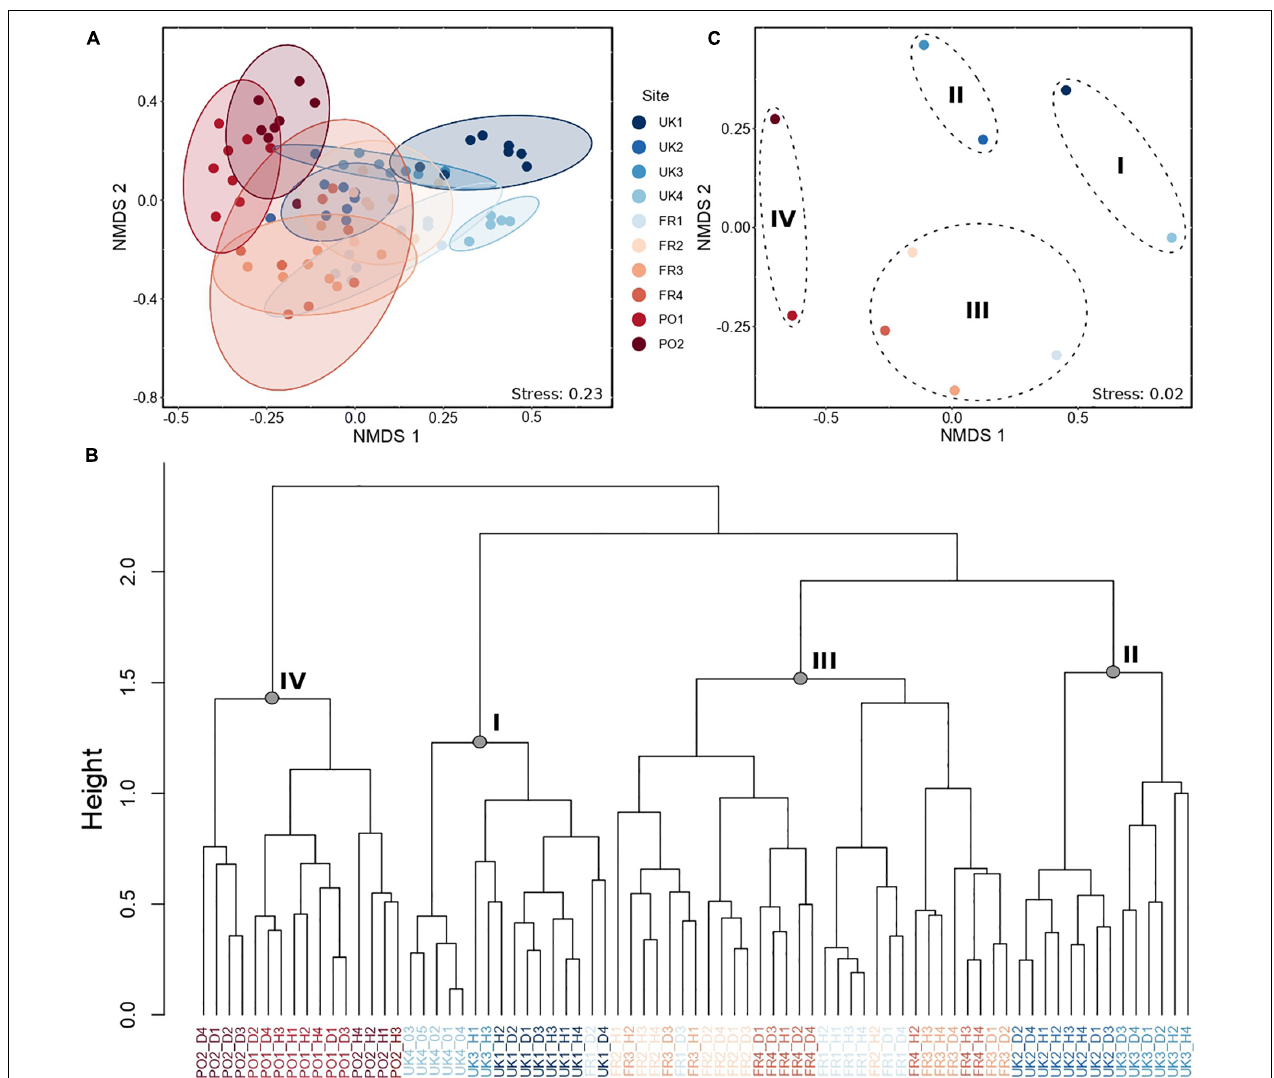
FIGURE 2 | (A) nMDS representing the variability across sites and stations within sites. (B) Cluster constructed using the “Ward D2”’ method, showing the four groups of replicates. Height indicates the order in which the clusters were joined. (C) nMDS constructed from data averaged for each site, grouped by cluster groups. A–C were derived from a Bray–Curtis dissimilarity matrix constructed from log ( x + 1) abundance data